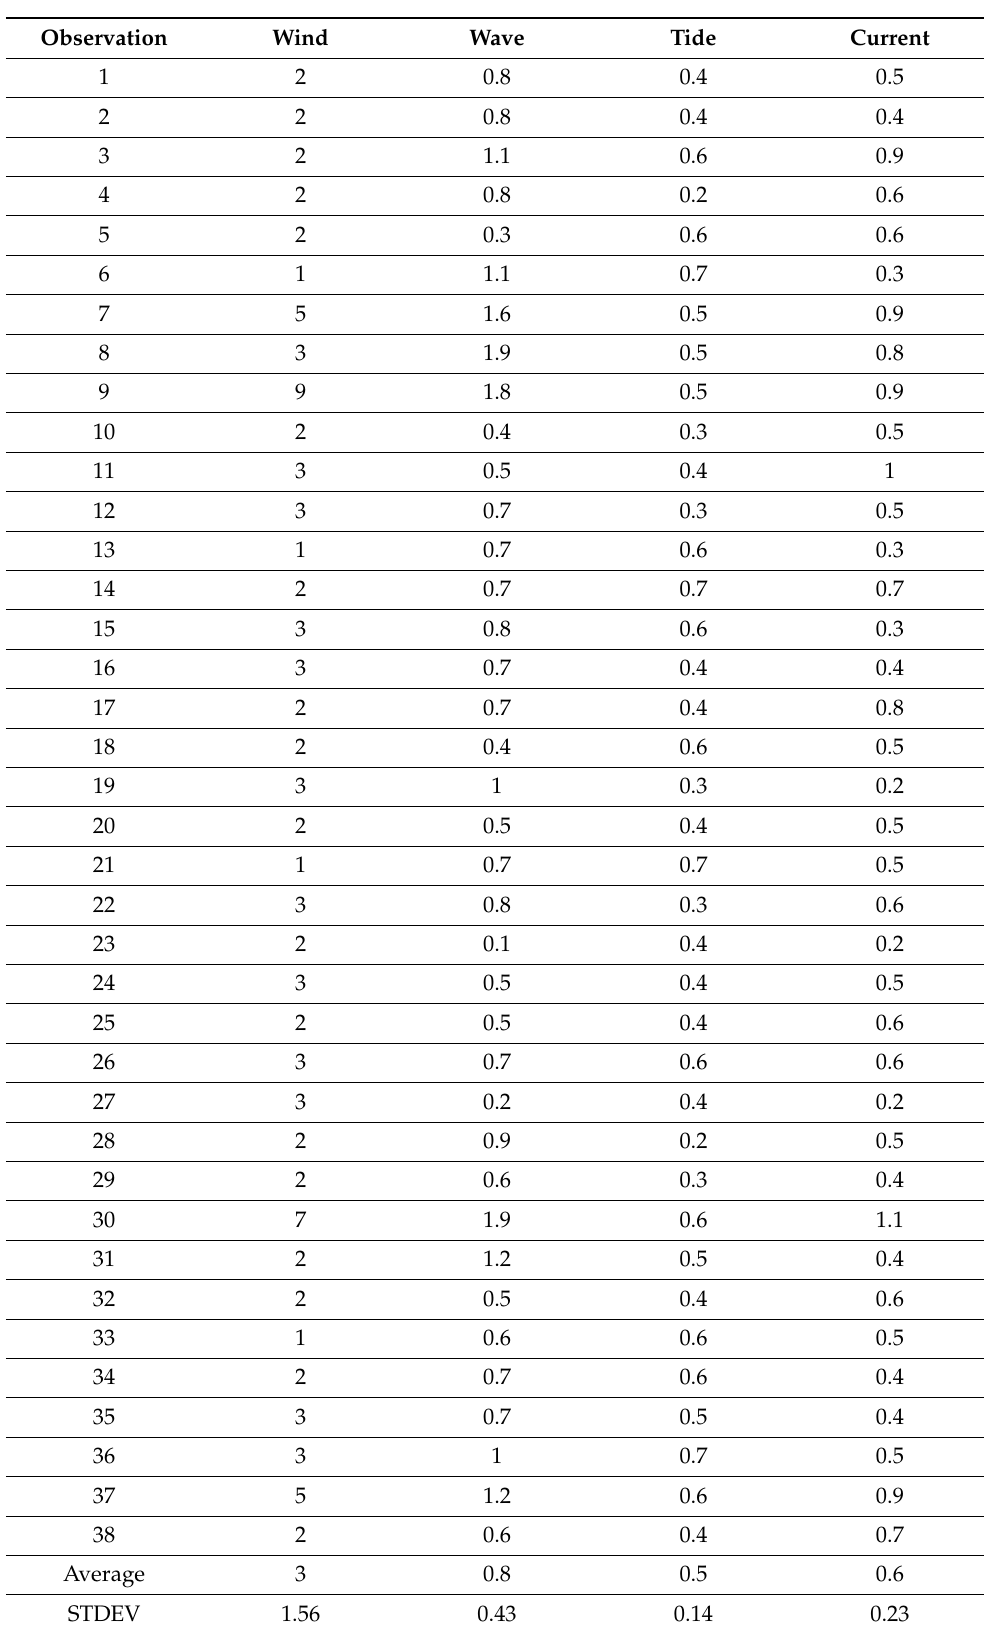
Table 1. The data of wind, waves, tide, and current.